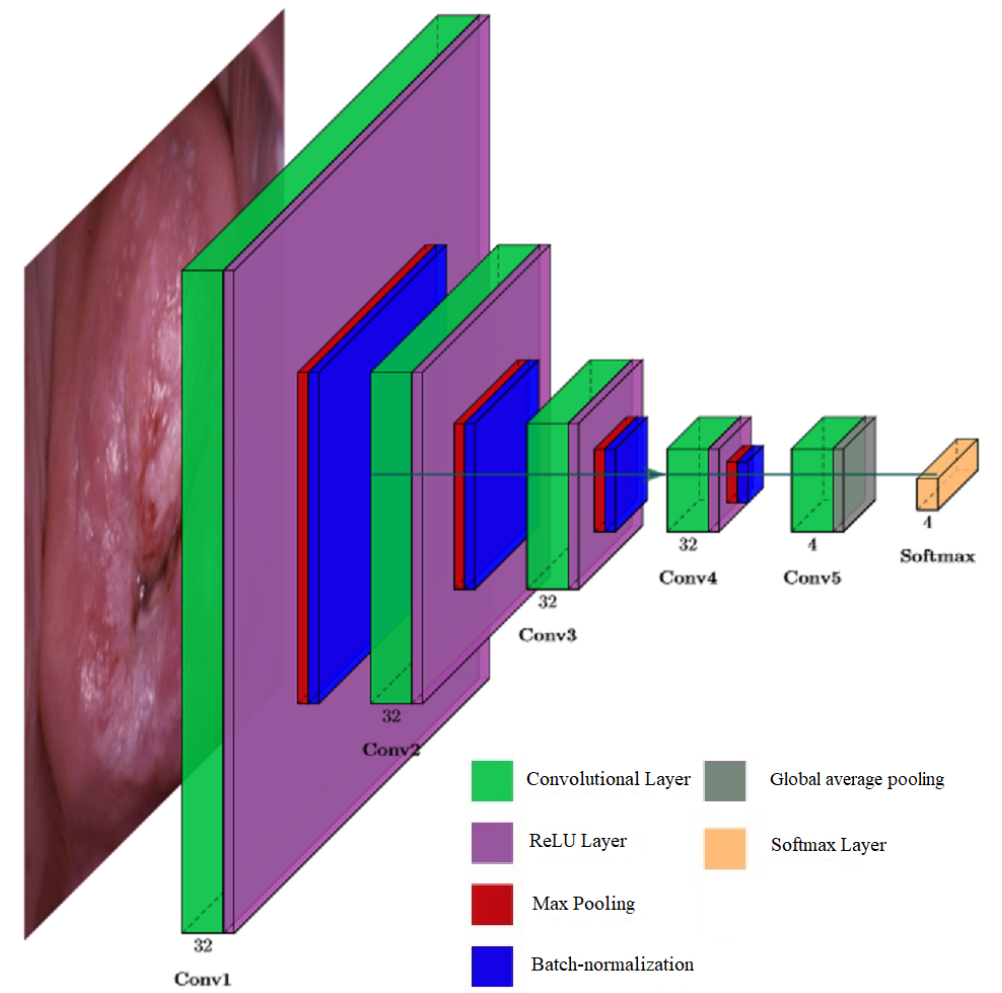
Figure 4. CNN Classifier